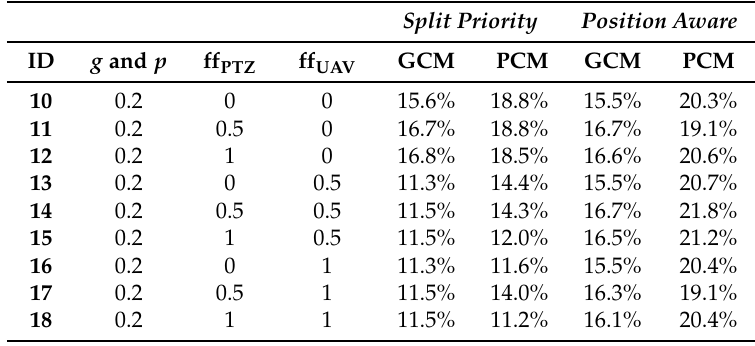
Table 2. Results of the simulations with method split priority and position aware . Split Priority